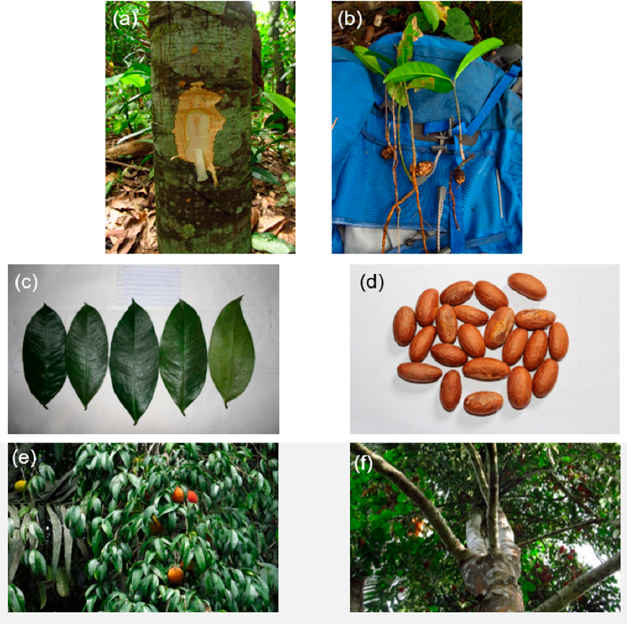
Figure 2. Morphological features of Garcinia kola . ( a ) bark with a fresh cut; ( b ) seedlings; ( c ) leaf collection from one tree; ( d ) seeds obtained in Yaoundé market; ( e ) branches with ripening fruits; ( f ) trunk with typical irregular branching pattern. Source: author’s archive.